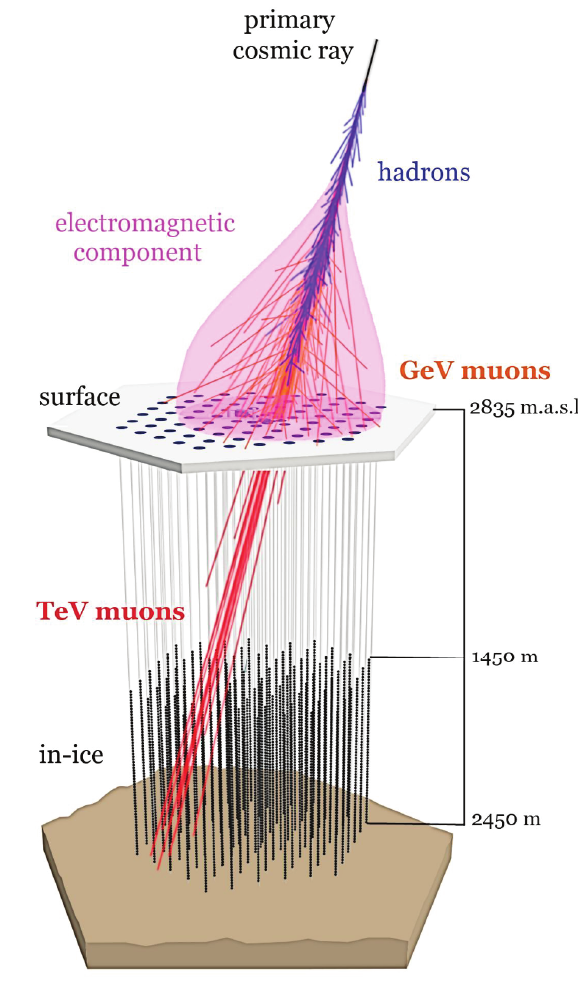
Figure 1: Air shower measurements of the IceCube Neu- trino Observatory with the in-ice IceCube and surface Ice- Top array [2].